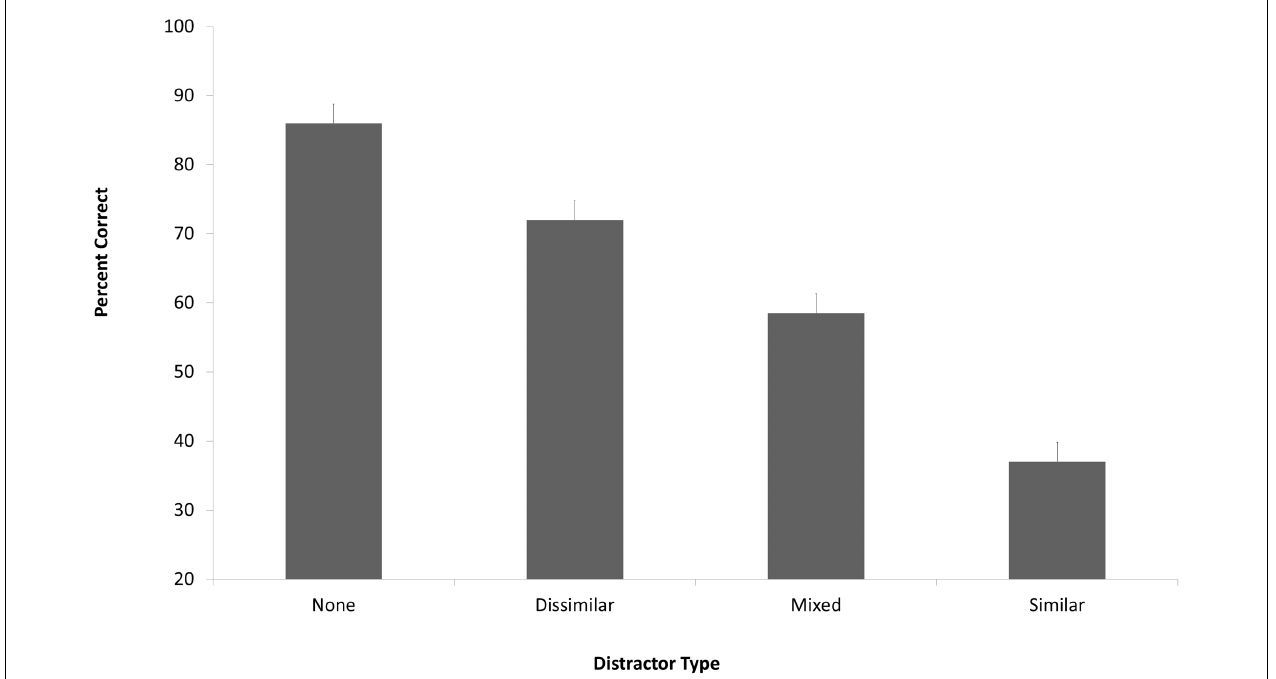
zero (leftmost bar) or 10 (other bars).The distracters were made up of 10 topically dissimilar images, 10 topically similar images, or an equal mixture of the two (5 similar and 5 dissimilar). Error bars show 1